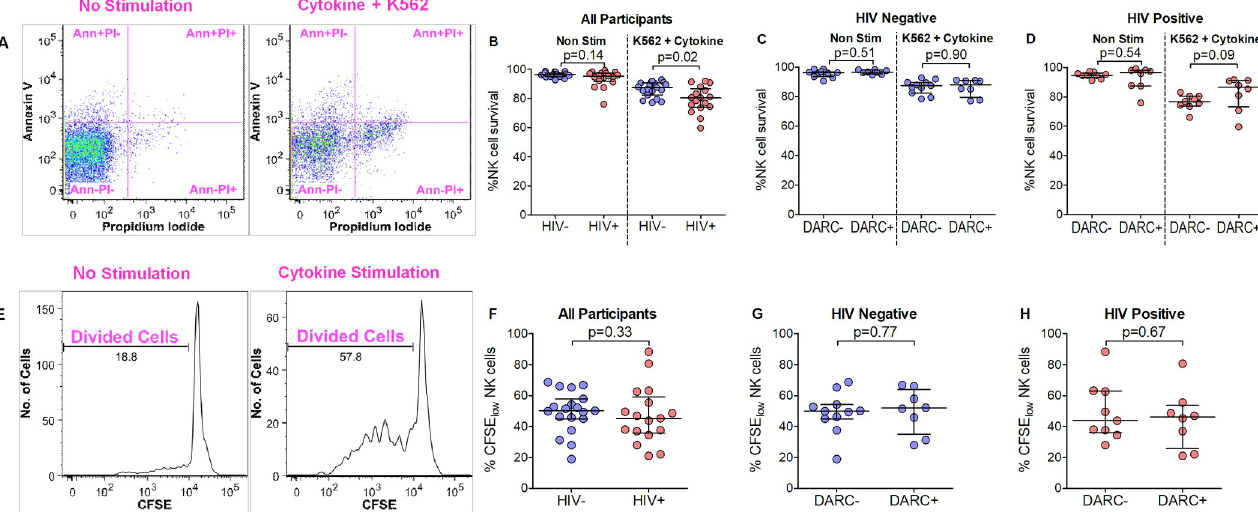
Fig 4. NK cell survival and proliferation measurement. (A) Gating strategy of Annexin V and propidium iodide on total NK cells. NK cells that survived were identified as Annexin (Ann)-PI-. (B) Percentage of NK cell survival for unstimulated and K-562+cytokine stimulated cells in all participants. Participants were further stratified to show percentage of NK survival for unstimulated and K-562+cytokine stimulated cells in HIV negative (C) and HIV positive (D) individuals by DARC trait. (E) Gating strategy of CFSE labeling on total NK cells. (F) Percentage of NK cells divisions (CFSE low) in all participants. Participants were further stratified to show percentage of NK cells divided in HIV negative (G) and HIV positive (H) individuals by DARC trait. Dots indicate individual data points. Medians are indicated and extended to interquartile range with whiskers. Abbreviations: DARC, Duffy antigen receptor for chemokines; CFSE, carboxyfluorescein succinimidyl ester.